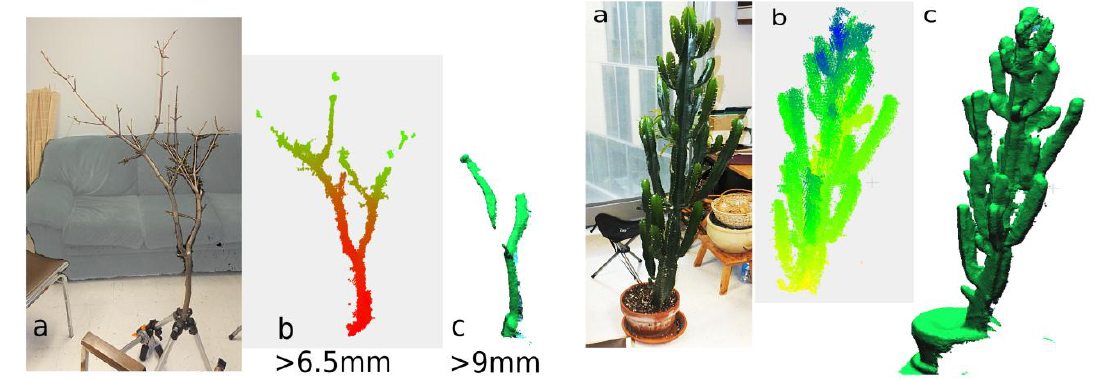
Figure 7. Examples of 3D scanning of real plants. Maple branching system at left, and cactus-like euphorbia tree at right: ( a ) photograph; ( b ) point cloud based on 5 merged static scans *; ( c ) wire-frame meshes obtain by the continuous 3D scanning (KinFu